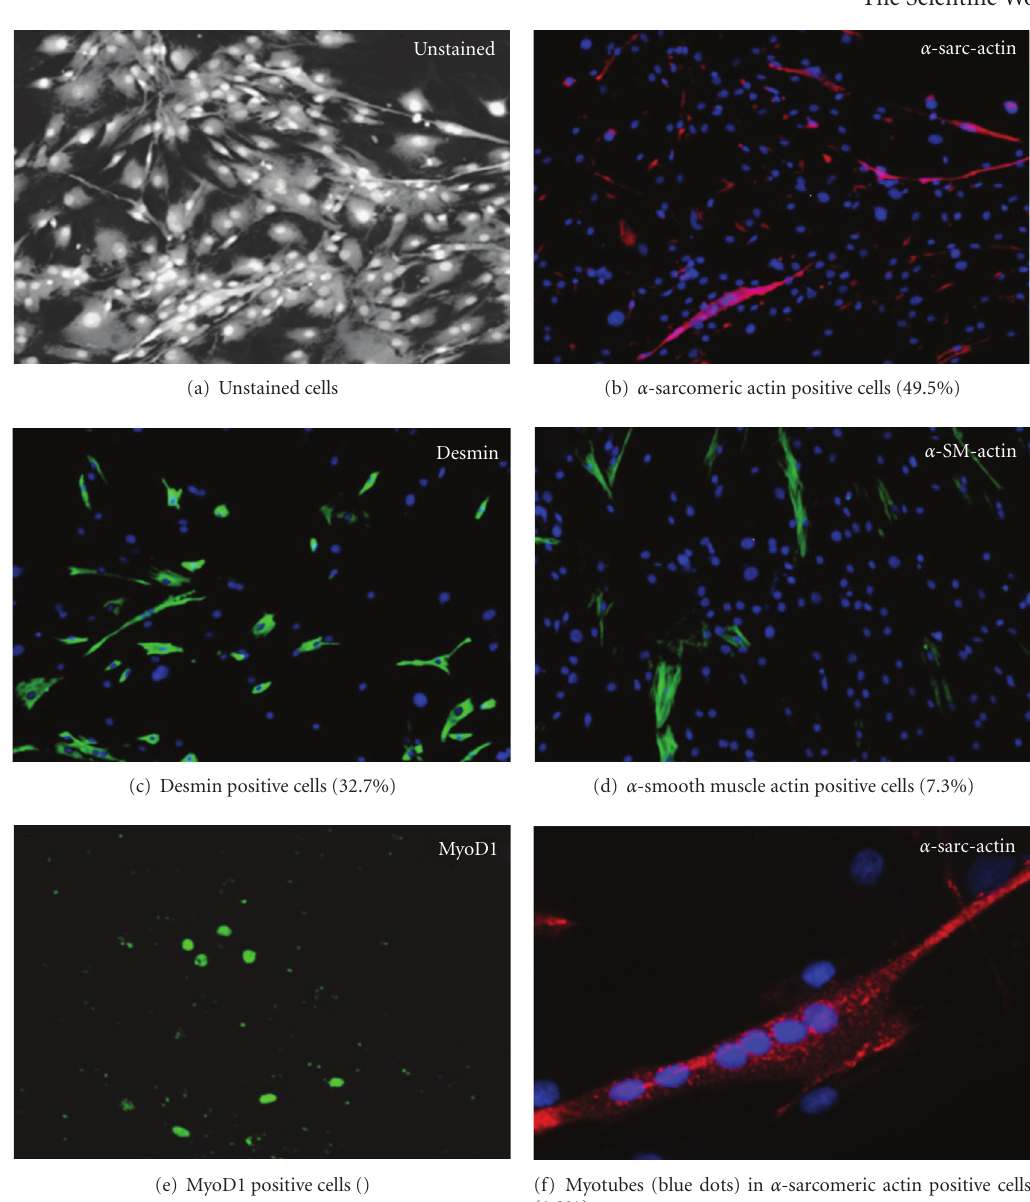
Figure 1: Immunostaining of cells prior to